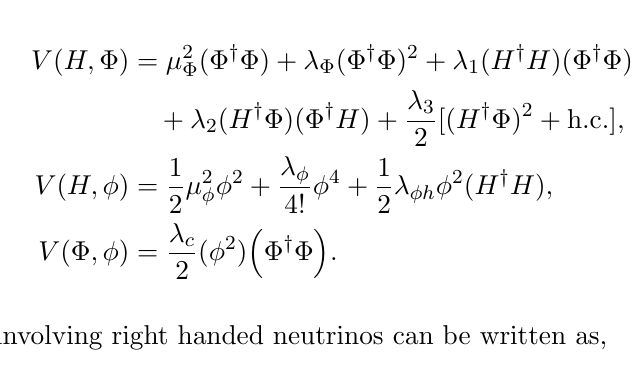
(cid:30) 2 ((cid:8) y (cid:8)) term. 2